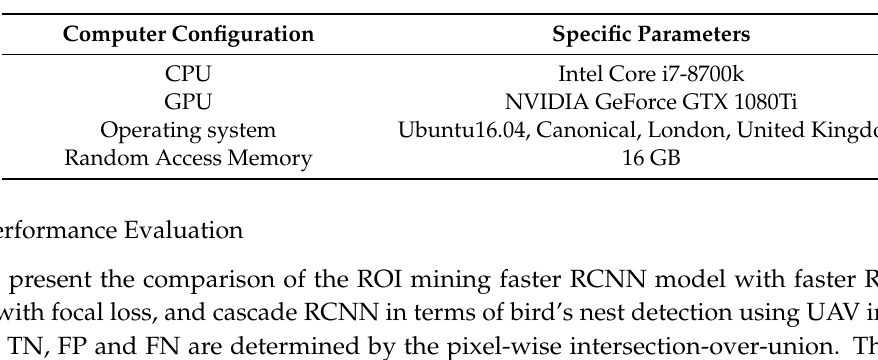
Table 1. Computer